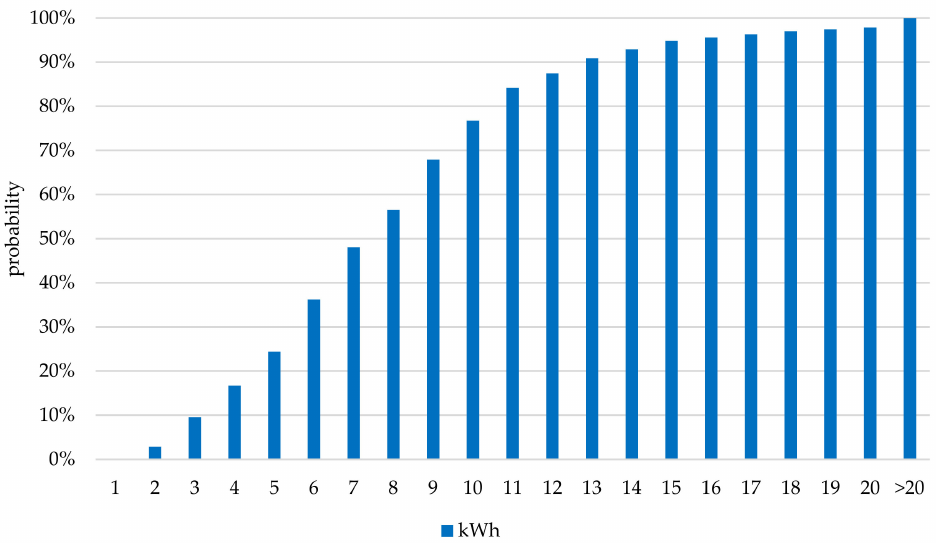
Figure 6. Cumulative distribution function of charging requirements [kWh] ([65], compiled and calculated by